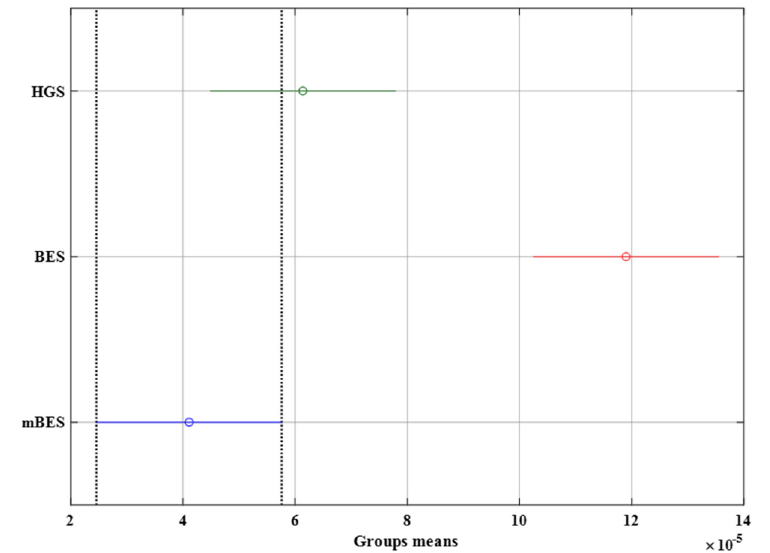
Table 6. ANOVA results for control.